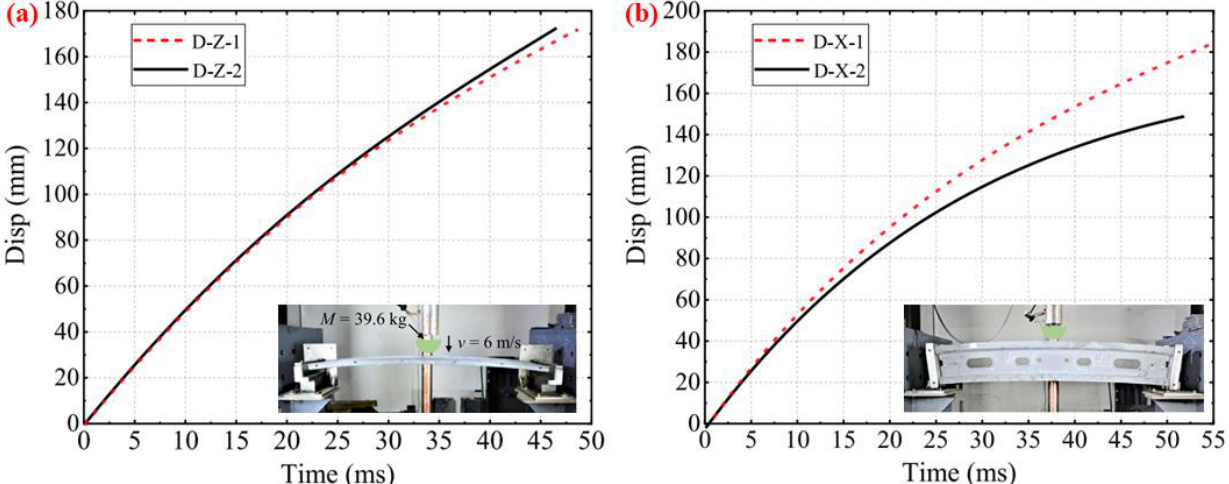
Figure 9. Displacement curves: ( a ) Z-directional tests, ( b ) X-directional tests.